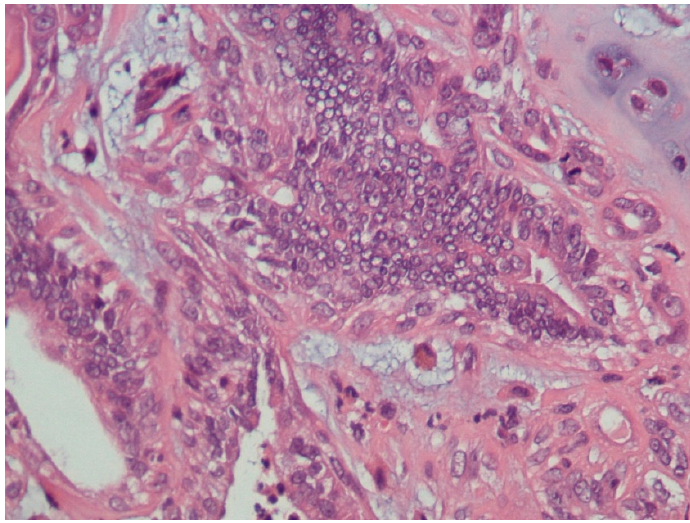
Figure 2. Canine mammary gland, ductal carcinoma (HE staining, 400×). The ducts are lined by a multilayered epithelium exhibiting considerable nuclear and cellular pleomorphism.